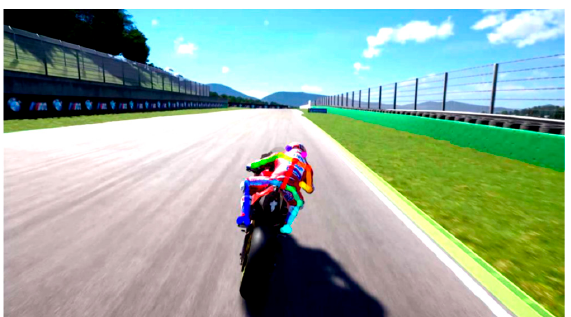
Figure 5. OpenPose postprocessing of MotoGP19 rear camera 1.